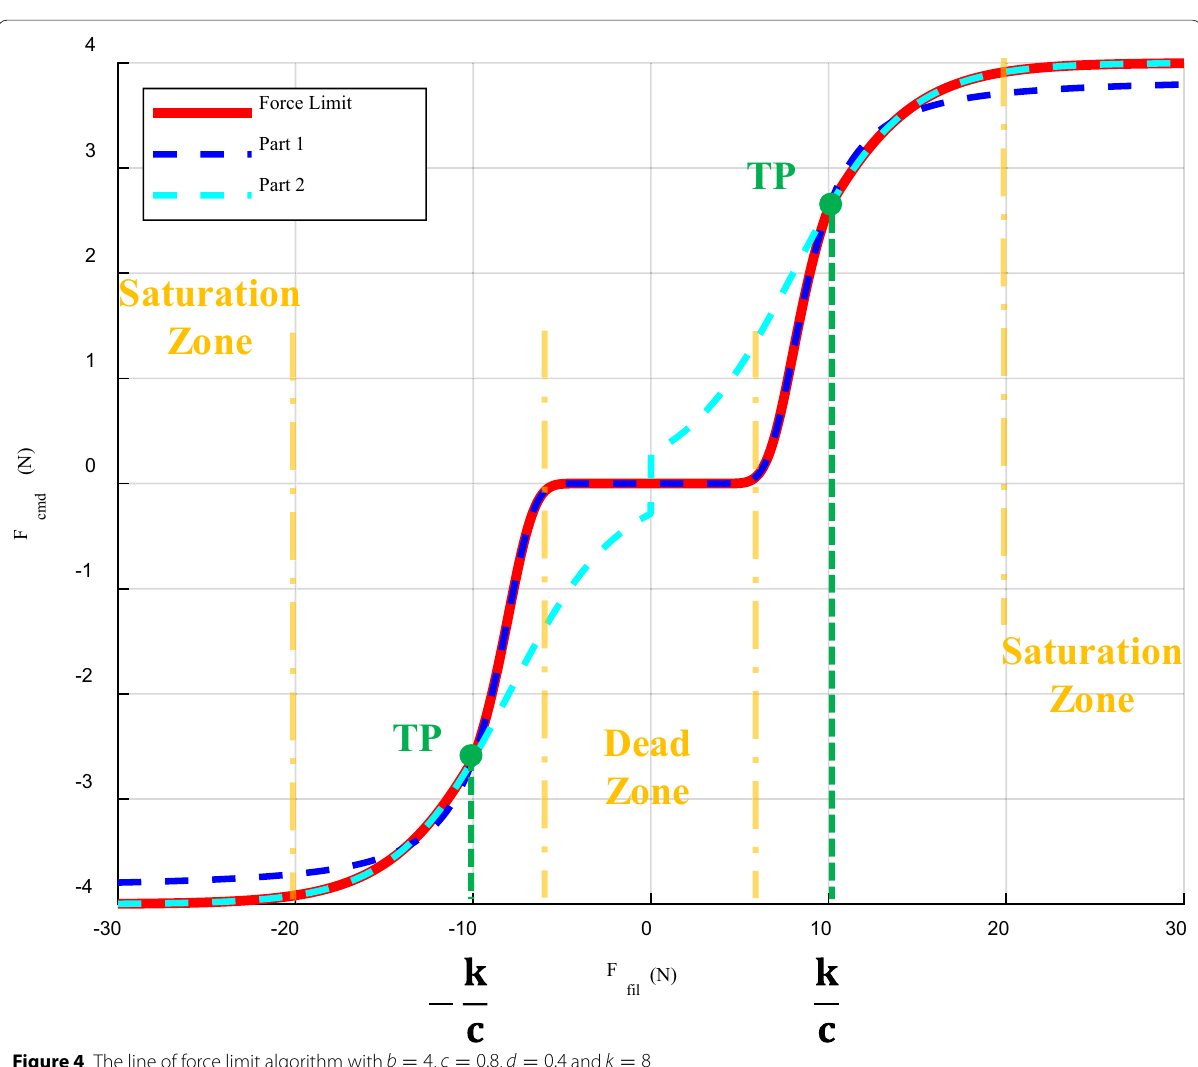
Figure 4 The line of force limit algorithm with b = 4 , c = 0.8 , d = 0.4 and k =